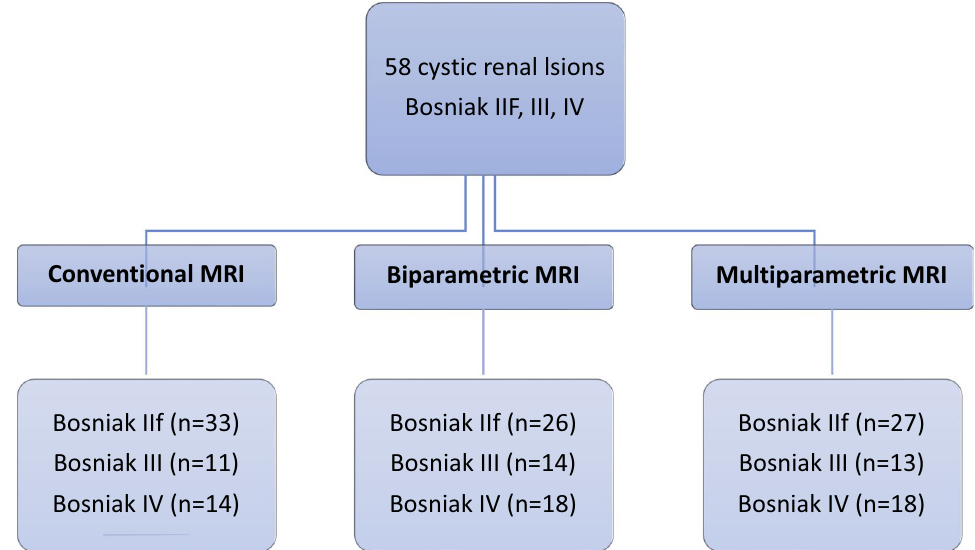
Fig. 4 Flowchart of Bosniak classification according to mp‑MRI compared to conventional and biparametric MRI